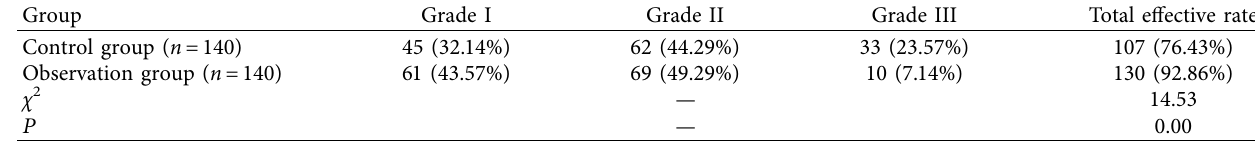
Table 1: Comparison of bowel cleaning efficiency between two groups of patients ( n (%)).